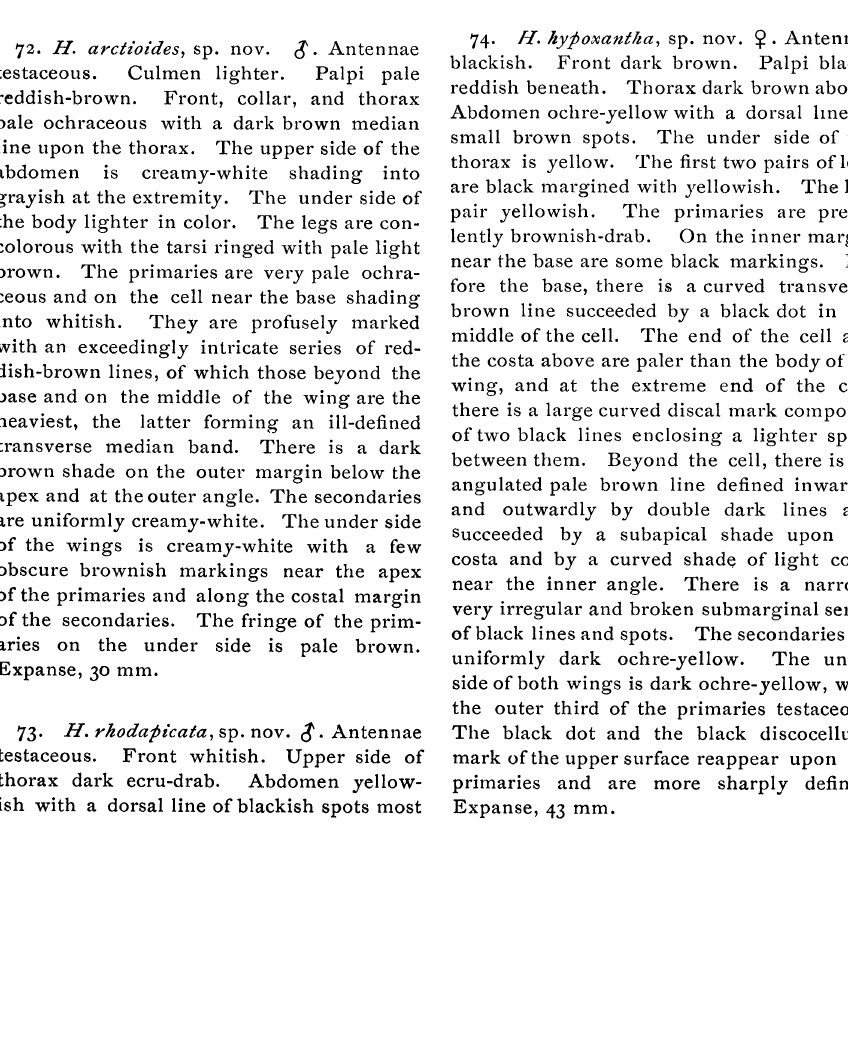
. Antennae 74. [t. kyiboxantka, sp. nov. blackish. Front dark brown. Palpi black, reddish beneath. Thorax dark brown above. Abdomen ochre-yellow with a dorsal line of small brown spots. The under side of the thorax is yellow. The first two pairs of legs are black margined with yellowish. The last pair yellowish. The primaries are preva- lently brownish-drab. On the inner margin near the base are some black markings. Be- fore the base, there is a curved transverse brown line succeeded by a black dot in the middle of the cell. The end of the cell and the costa above are paler than the body of the wing, and at the extreme end of the cell, there is a large curved discal mark composed of two black lines enclosing a lighter space between them. Beyond the cell, there is an angulated pale brown line defined inwardly and outwardly by double dark lines and Succeeded by a subapical shade upon the costa and by a curved shade of light color near the inner angle. There is a narrow, very irregular and broken submarginal series . of black lines and spots. The secondaries are uniformly dark ochre-yellow. The under side of both wings is dark ochre-yellow, with the outer third of the primaries testaceous. Antennae The black dot and the black discocellular testaceous. Front whitish. Upper side of mark of the upper surface reappear upon the thorax dark ecru-drab. Abdomen yellow- primaries and are more sharply defined. Expanse, 43 ish with a dorsal line of blackish spots most